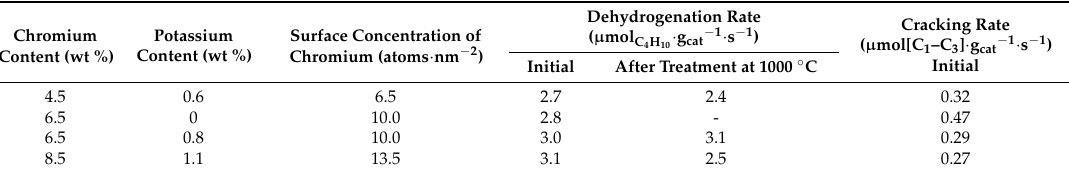
Figure 8. X ‐ ray diffraction patterns of catalysts. Figure 8. X-ray diffraction patterns of catalysts. Table 4. The composition of catalysts and their performance in isobutane dehydrogenation. Chromium Content (wt